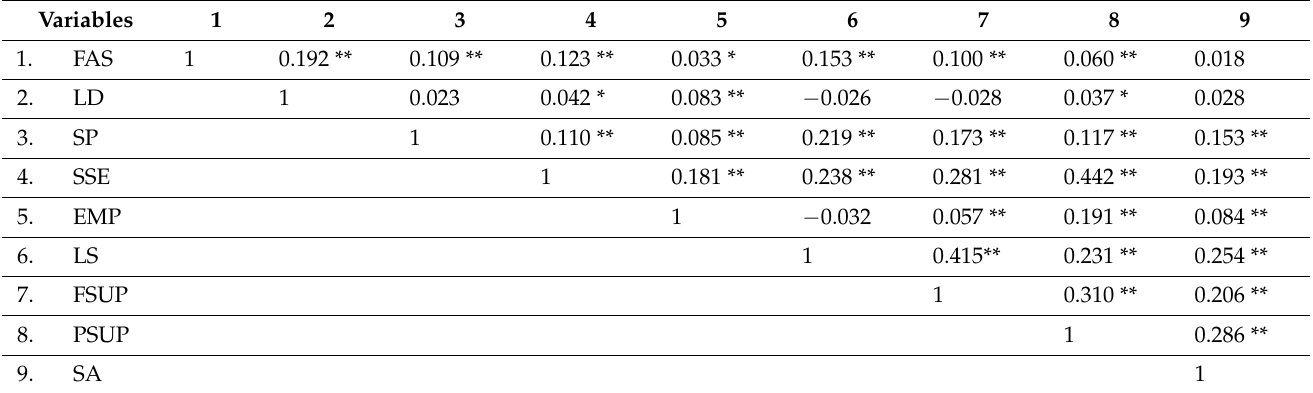
Table 4. The correlations of psychosocial determinants of bullying and cyberbullying perpetration. (Spearman’s